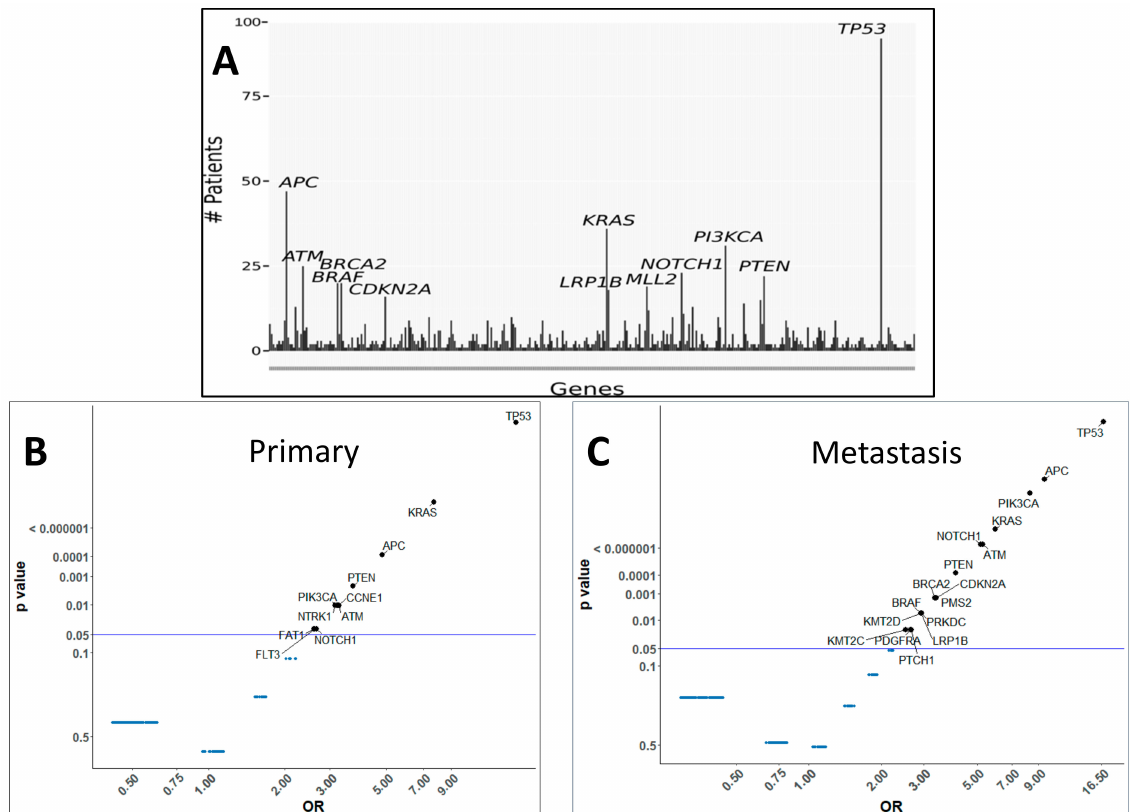
Figure 1. The mutation frequency of the common drivers of malignancy. ( A ) Most frequently mutated genes for 171 ad- vanced cancer patients in study. Top 12 mutated genes labeled with gene name. Plot showing representation of gene mutations with significance ( p -values < 0.05) across ( B ) primary samples and ( C ) metastatic samples. Y-axis is p -value and X-axis is the odds ratio. Significant genes are labeled and